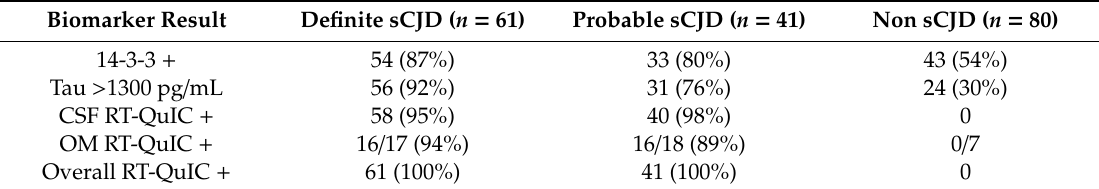
Table 3. Surrogate biomarkers and real-time quaking-induced conversion (RT-QuIC) testing in CSF and olfactory mucosa (OM) samples of the overall tested subjects.